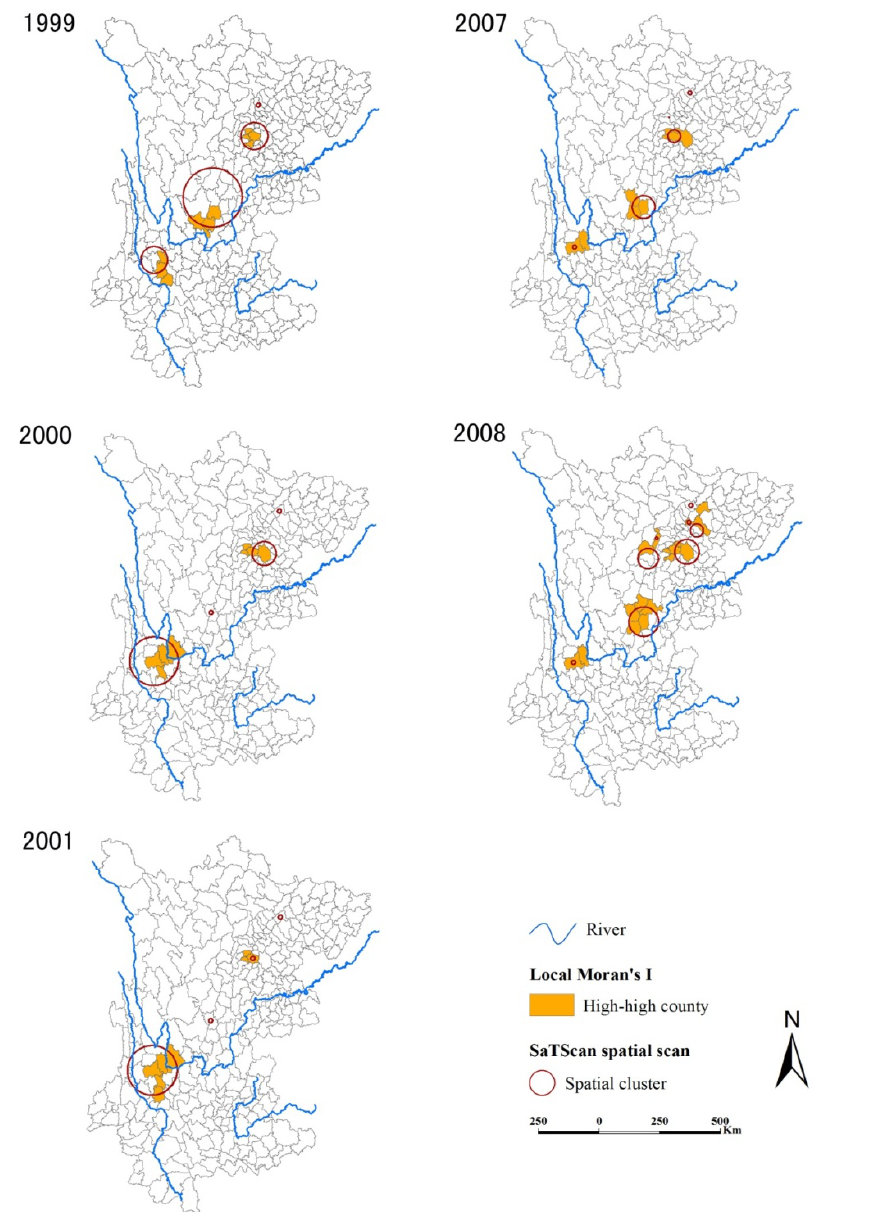
Figure 3. Annual spatial clusters of schistosomiasis during the two study